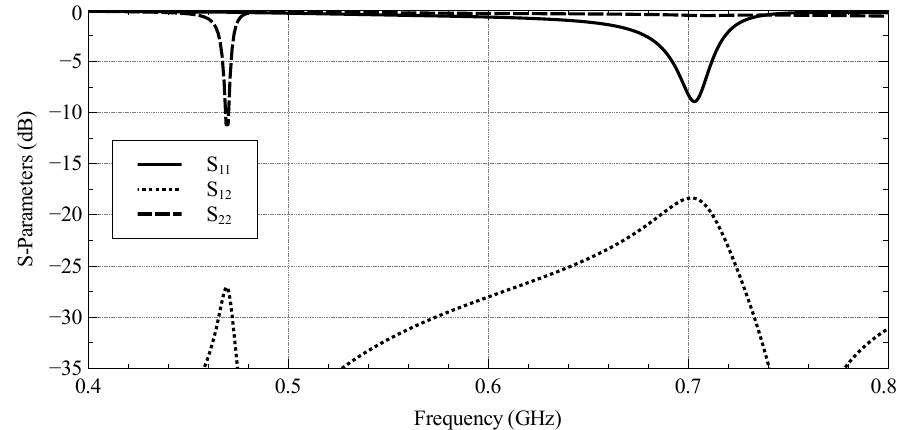
Figure 6. Simulated S-parameters of antennas with Configuration 1.